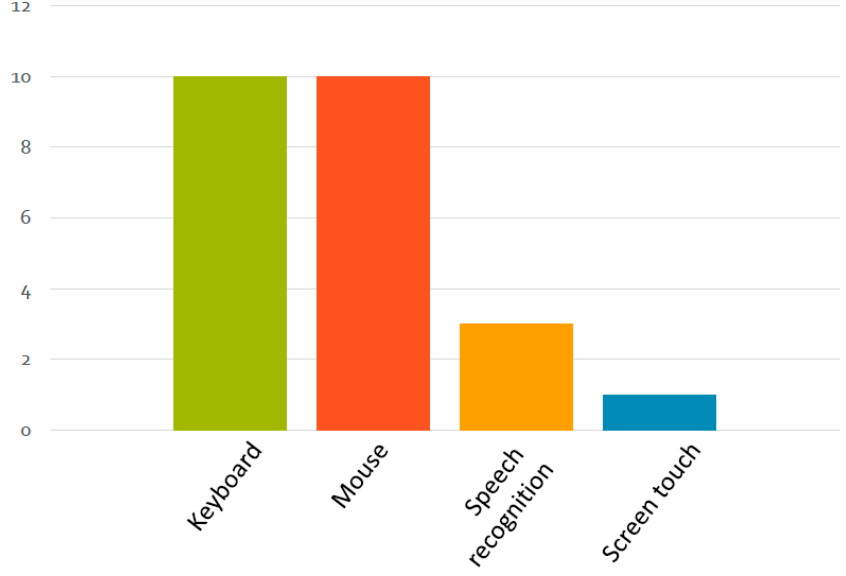
Figure 8. Participants’ demographics: experience of input modes prior to the experiment.